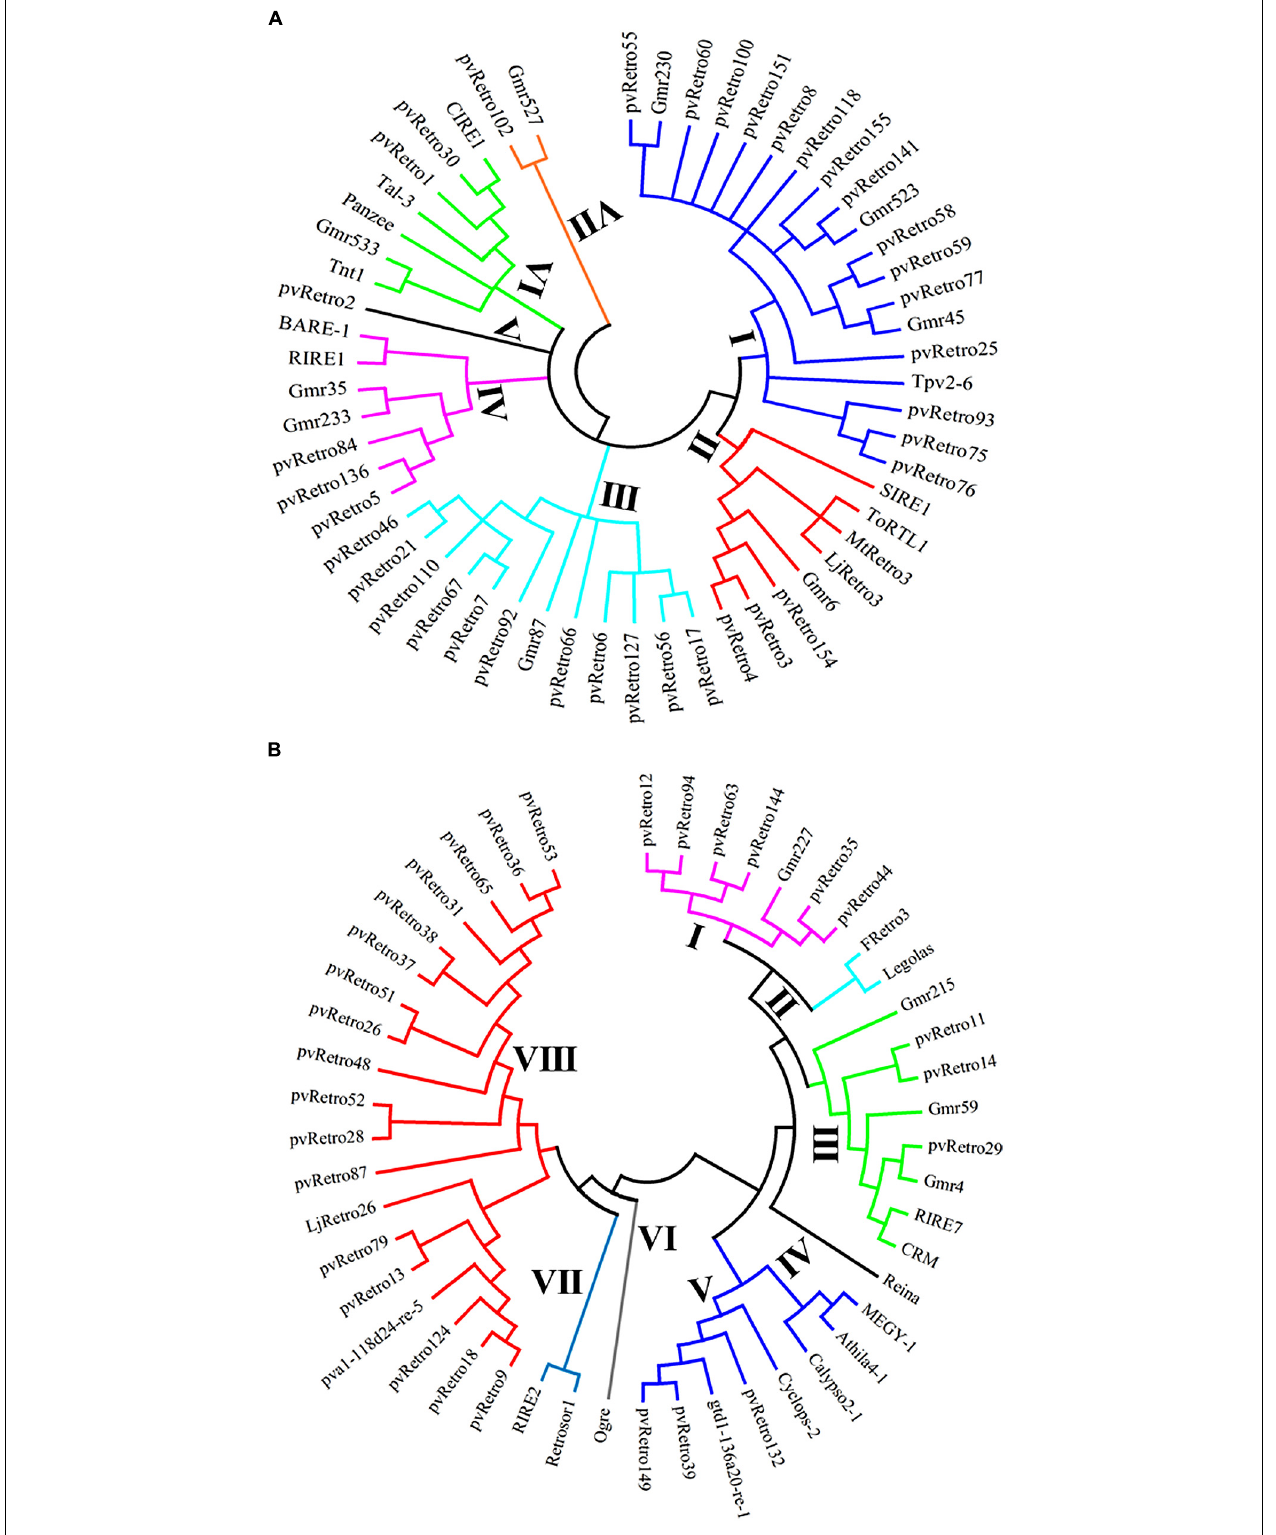
FIGURE 3 | Phylogenetic tree using the conserved RT domains ofTy1-copia (A) andTy3-gypsy (B) LTR retrotransposons.